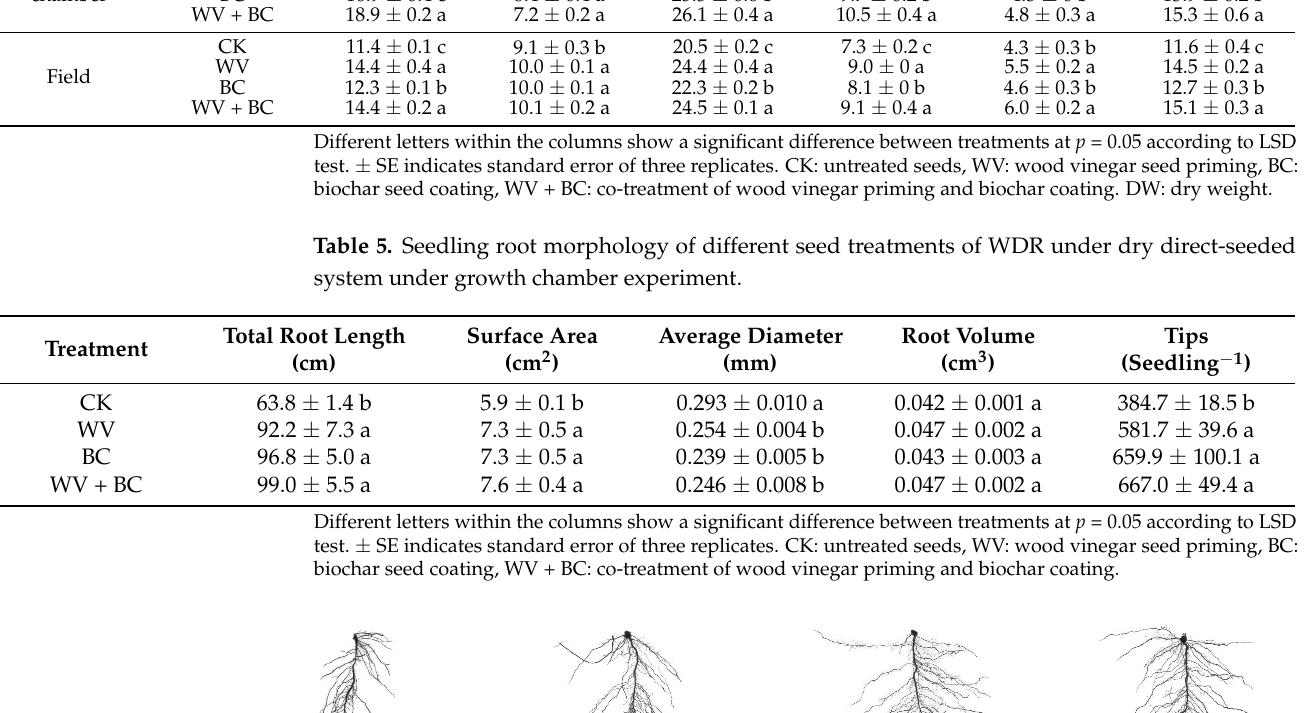
Table 5. Seedling root morphology of different seed treatments of WDR under dry direct-seeded system under growth chamber experiment.